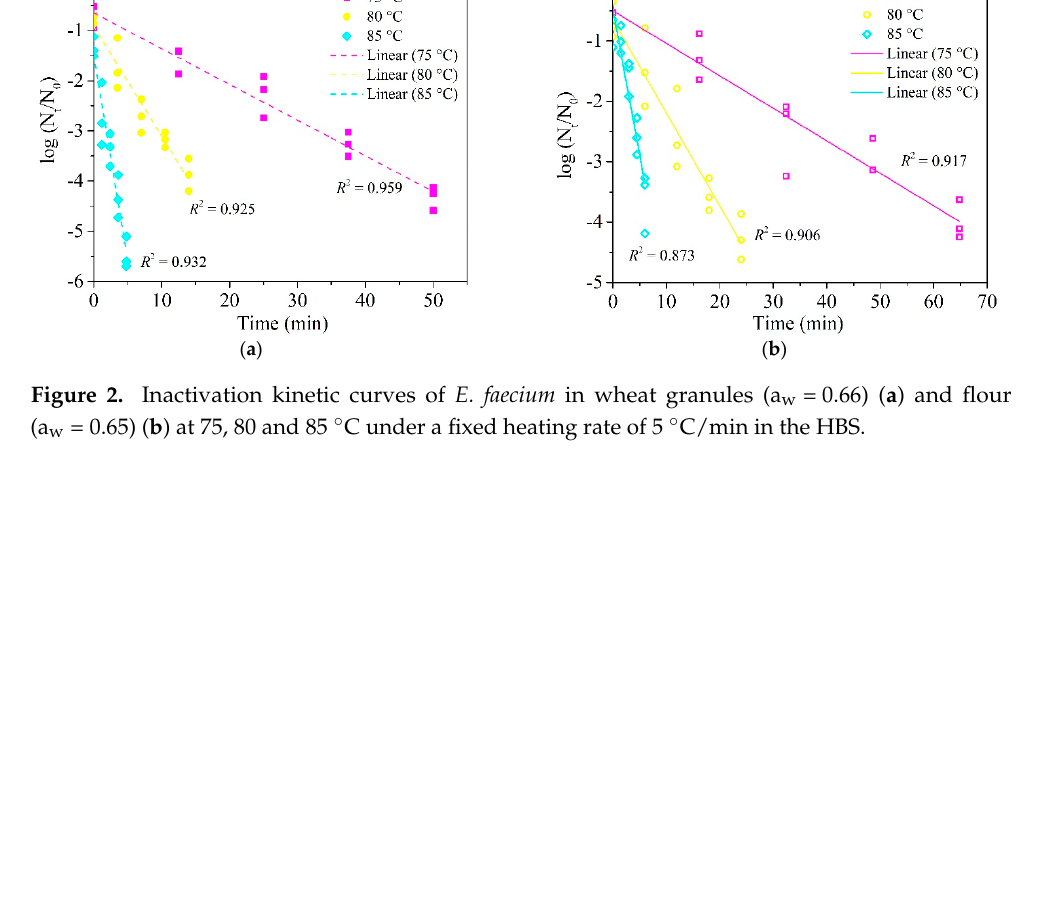
Figure 3. Inactivation kinetic curves of E. faecium in wheat granules ( a ) (a w = 0.99) and dough ( b ) (a w = 0.99) at 60, 62 and 64 °C under a fixed heating rate of 5 °C/min in the HBS. The authors apologize for any inconvenience caused to the readers by these changes.